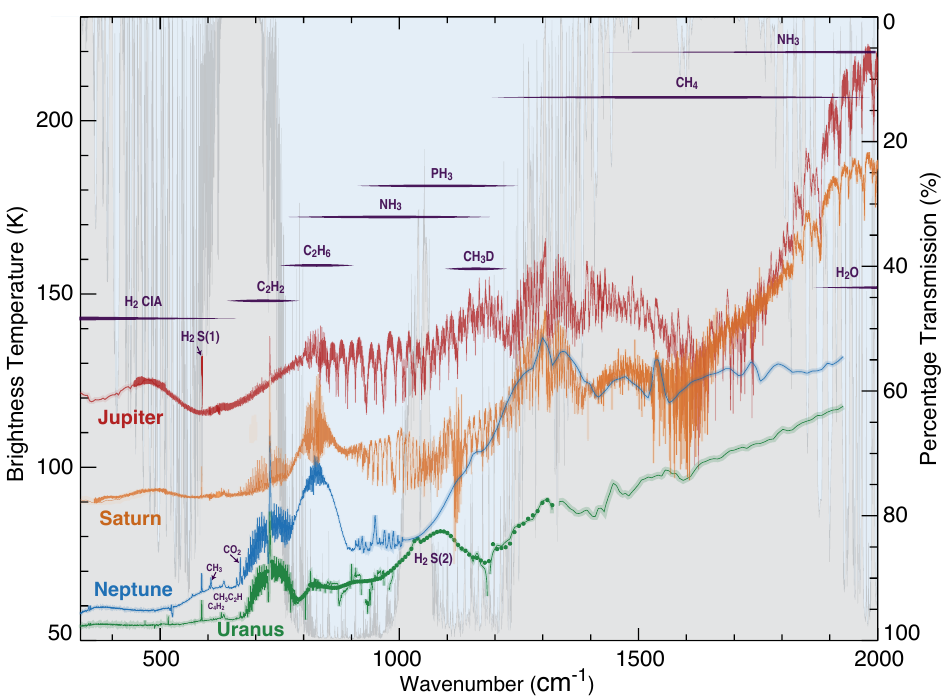
Figure 10. As in Figure 9, mid-infrared spectra of the giant planets, but now expressed in brightness temperature versus spectroscopic